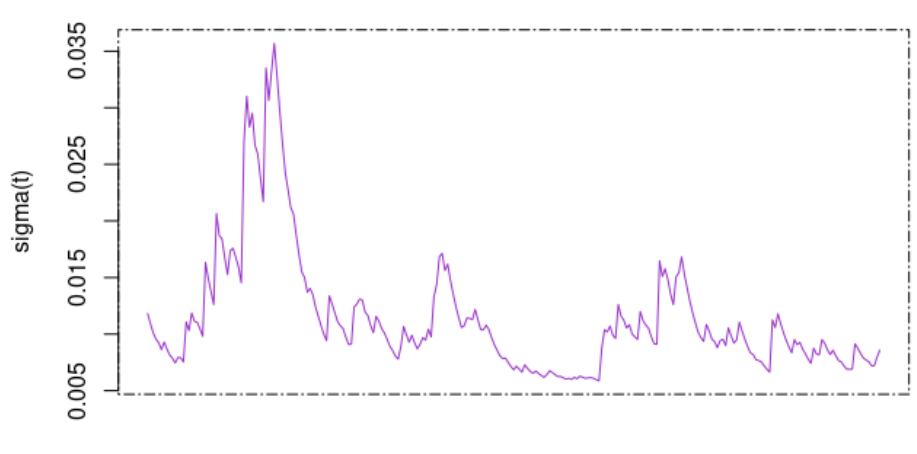
Figure 18. Volatility extracted from AR(1)-GJR-GARCH(1,1) model for Tether Gold (TETHER _ G)—